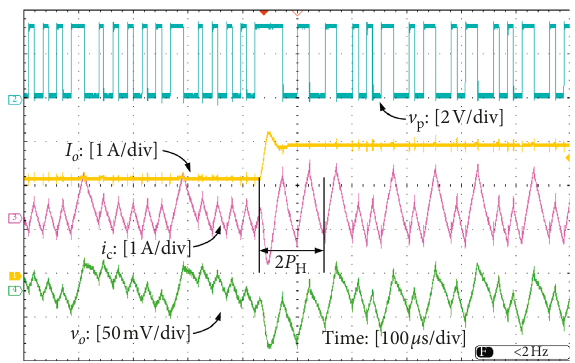
Figure 9: Experimental transient waveforms of the DCPT-controlled buck converter while load